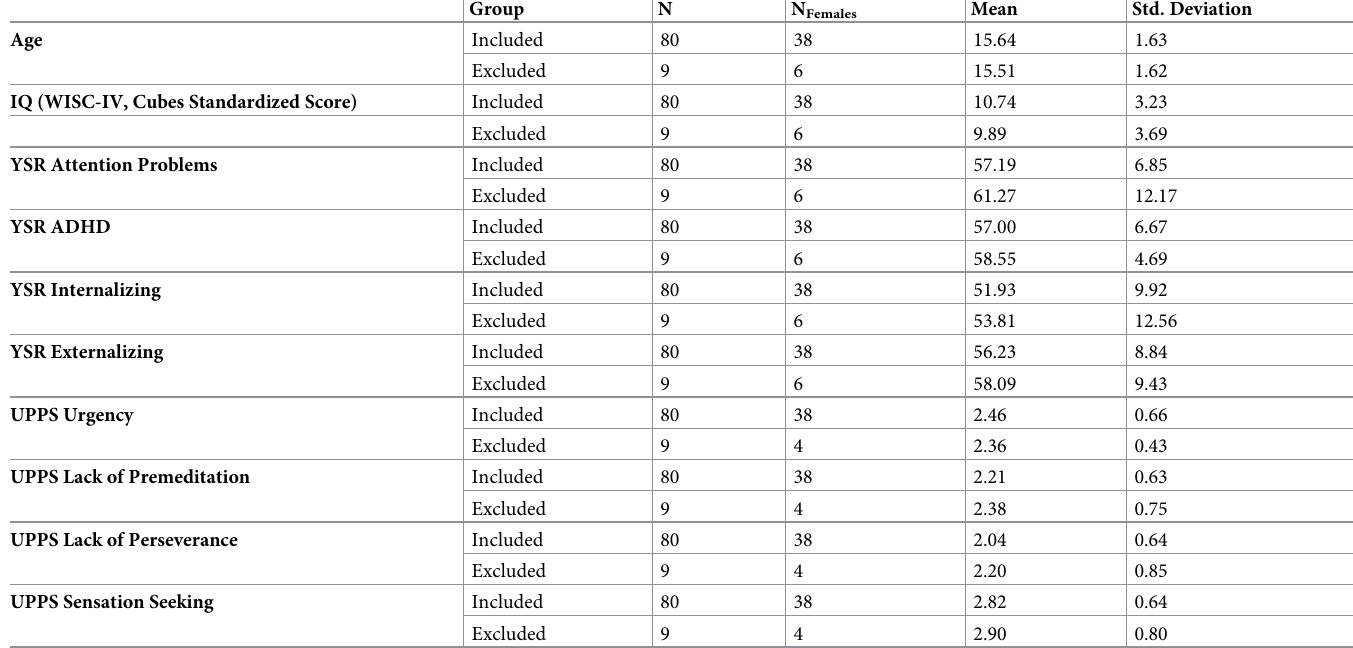
Table 1. All participants demographic and behavioral data. Demographic data, means and standard deviations for all behavioral measures of interest for included and excluded